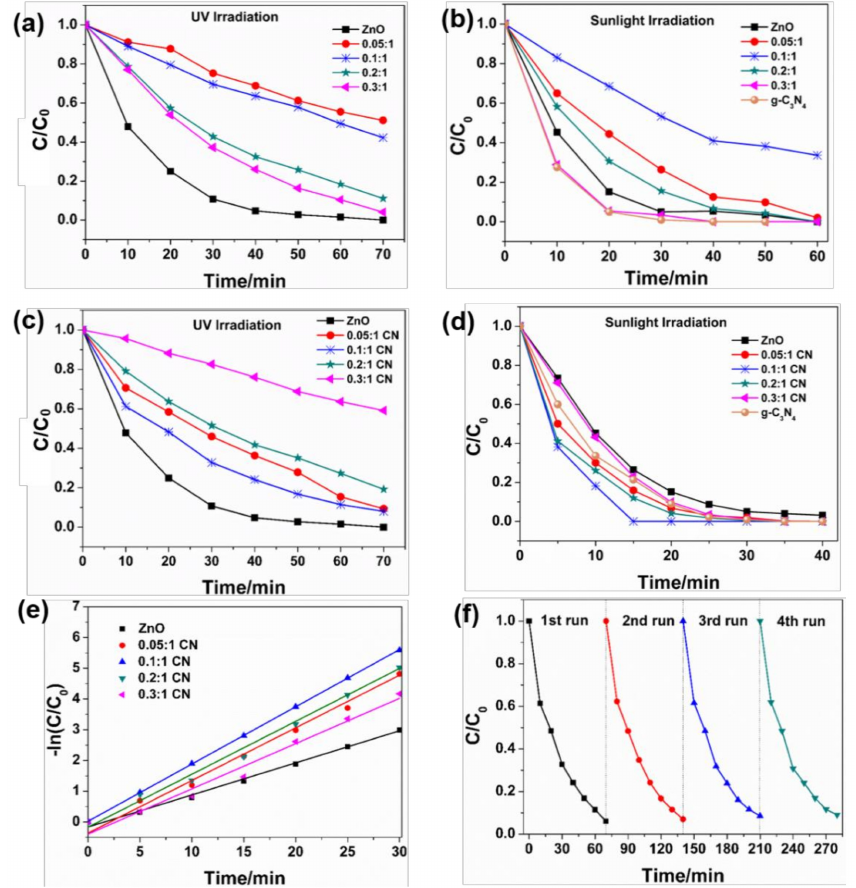
Figure 7. Degradation rate of methyl blue (MB) under ultraviolet ( a , c ) and sunlight ( b , d ) irradiation, kinetic linear simulation over 0.1:1 CN photocatalyst ( e ) and stability study of MB degradation over 0.1:1